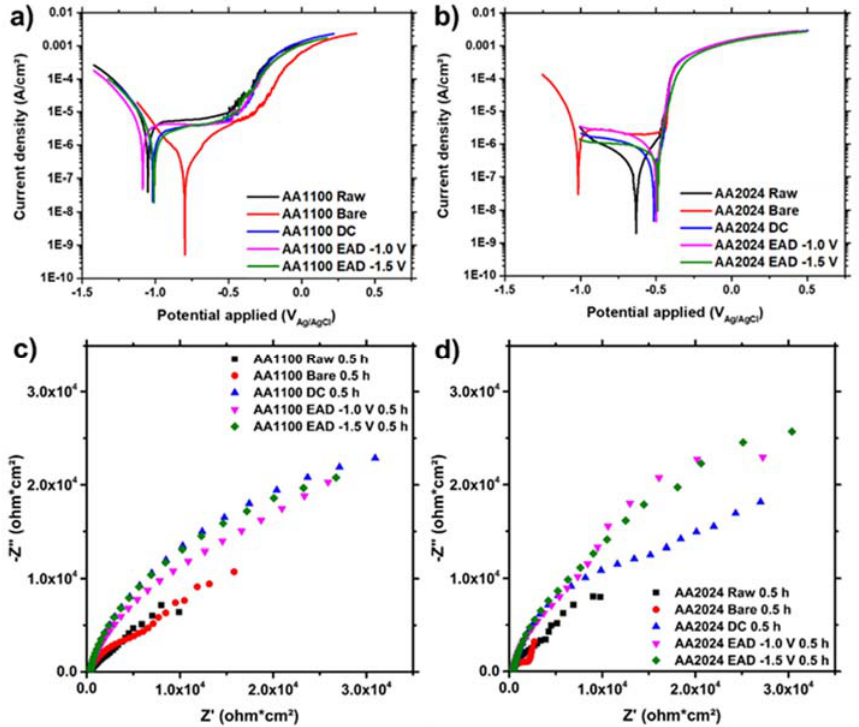
Figure 8. ( a , b ) Polarization curves and ( c , d ) Nyquist plots of AA1100 ( a , c ) and AA2024 ( b , d ) specimens after 30 min of immersion in aqueous NaCl 0.05 M electrolyte.